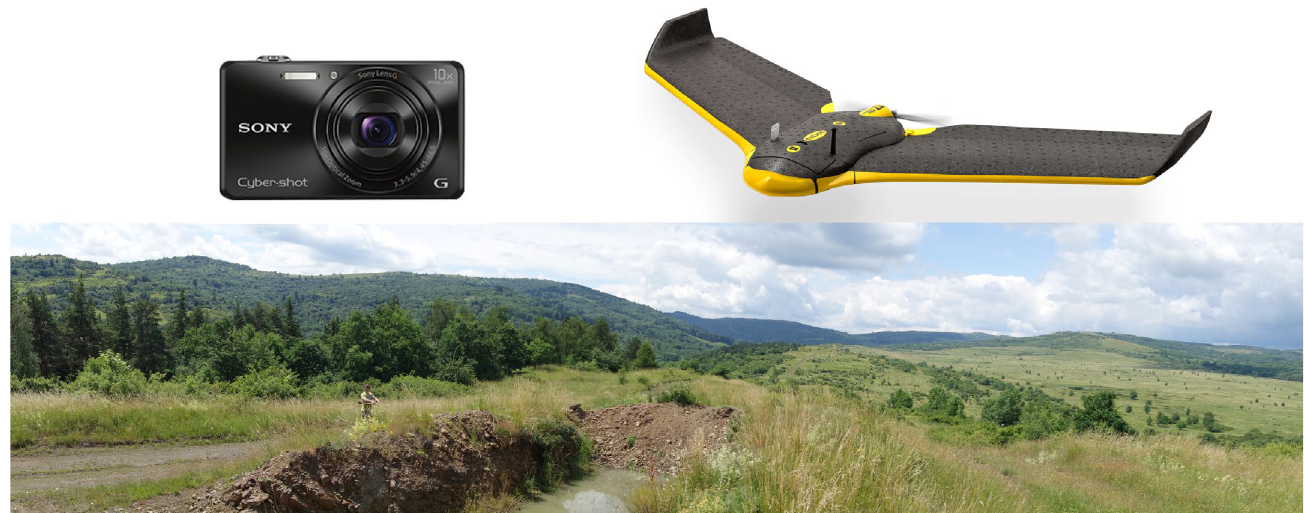
Figure 2. A broader view of the study area ( bottom ); the senseFly eBee equipped with a consumer- grade DSC-WX220 digital compact camera ( top ).